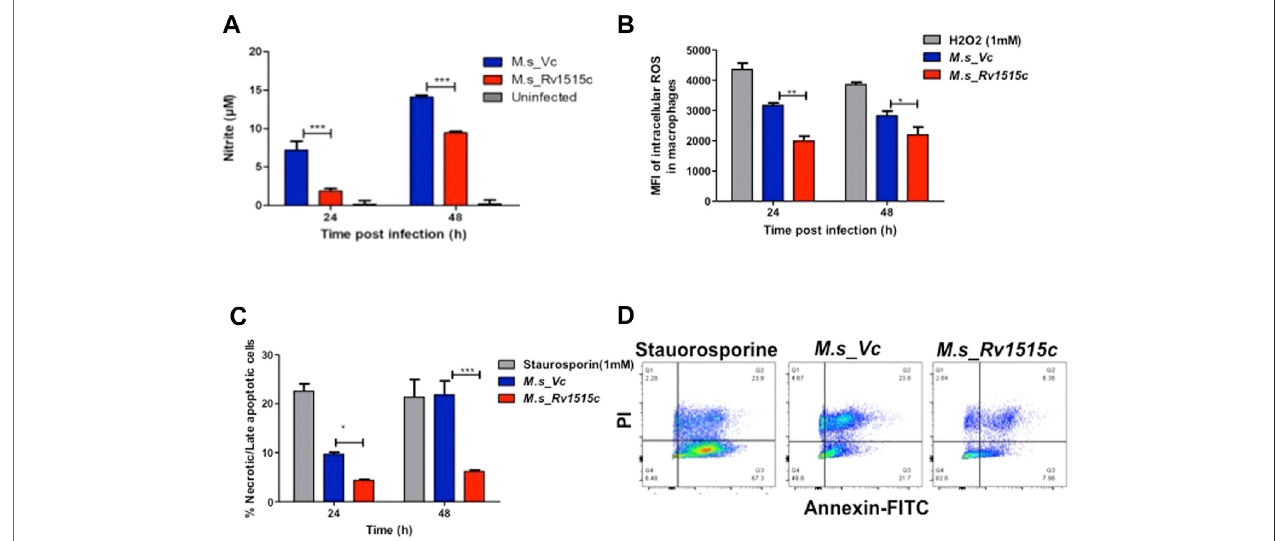
FIGURE 4 | Rv1515c decreases the production of ROS and NO, and arrests apoptosis in macrophages. RAW 264.7 cells (0.5 × 10 6 cells) were incubated with equal number of M. s _Vc and M. s _Rv1515c cells at a MOI of 1:10 for 24 and 48 h. (A) Griess reagent was added to the culture supernatant and level of NO was measured spectrophotometrically at 545 nm. Uninfected cells were used as control. (B) ROS level was analysed by fl ow cytometry post staining with CellROX Green dye.Mean fl